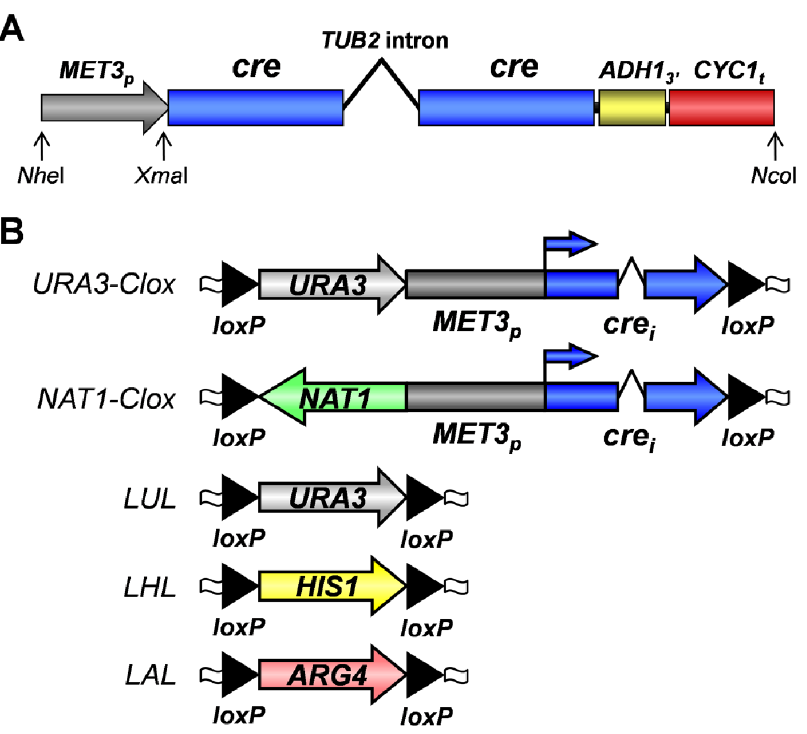
Figure 1. Structure of the synthetic cre gene and Clox disruption cassettes. (A) Cartoon illustrating the components of the synthetic cre gene including the CaMET3 promoter ( MET3 p : grey), the two codon-optimized cre exons (blue), the CaTUB2 intron, 3 9 -untranslated sequence from the CaADH1 gene (yellow), the transcriptional terminator from ScCYC1 (red), and engineered restriction sites for cloning. The DNA sequence of the synthetic cre exons and CaTUB2 intron is provided in Figure S1. (B) The Clox kit. Cartoons illustrating the structures of the URA3-Clox and NAT1-Clox cassettes (this study) and the LUL, LHL and LAL cassettes [25]; Black arrows, loxP sites; blue arrows, MET3 p -cre transcriptional start sites; open wavey boxes, common PCR priming sites for the disruption